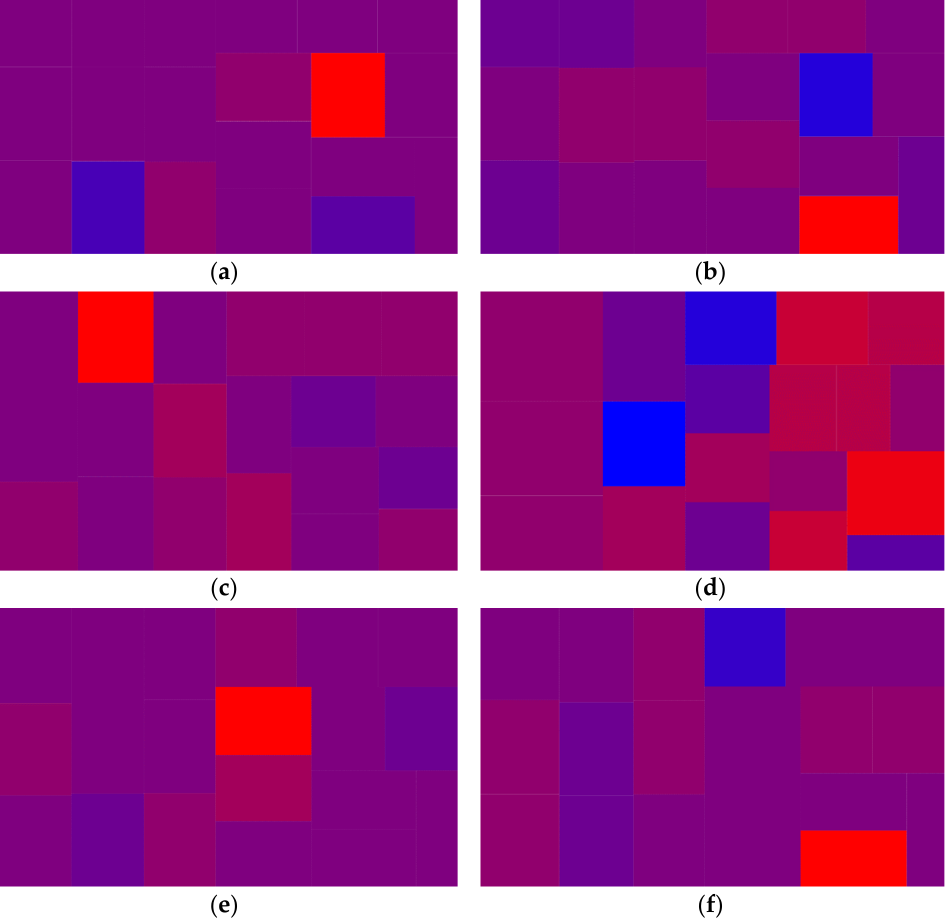
Figure 4. Heatmaps of the technical trading systems for the period 1 July 2012 to 30 June 2022 for each component stock. The size of each square indicates the number of trades generated from the trading rules, while the colours denote average net returns: blue (profits) and red (losses). ( a ) MACD; ( b ) D-MACD; ( c ) BB; ( d ) D-BB; ( e ) MACD-BB; ( f ) D-MACD-BB.